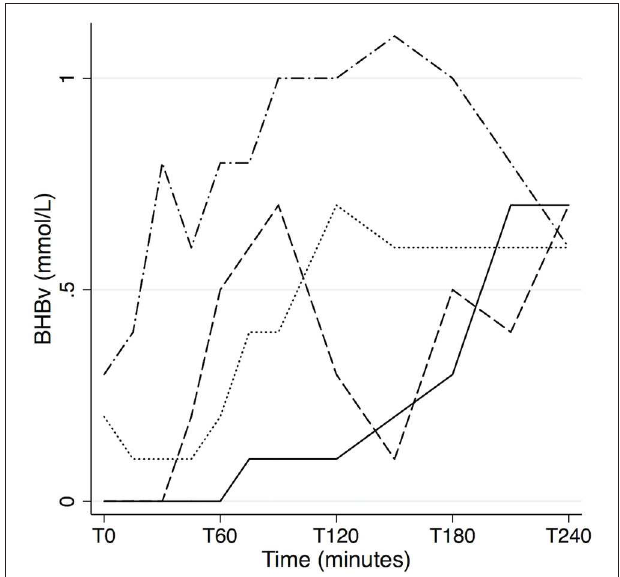
FIGURE 3 | Individual differences in the ketogenic response to C8. The paths of four subjects in the C8 arm (20g Caprylic acid + 10g Sunflower oil), selected to illustrate the big individual differences in BHBv response, and the potentially transient nature of ketosis. BHBv, β -hydroxybutyrate in venous whole blood.